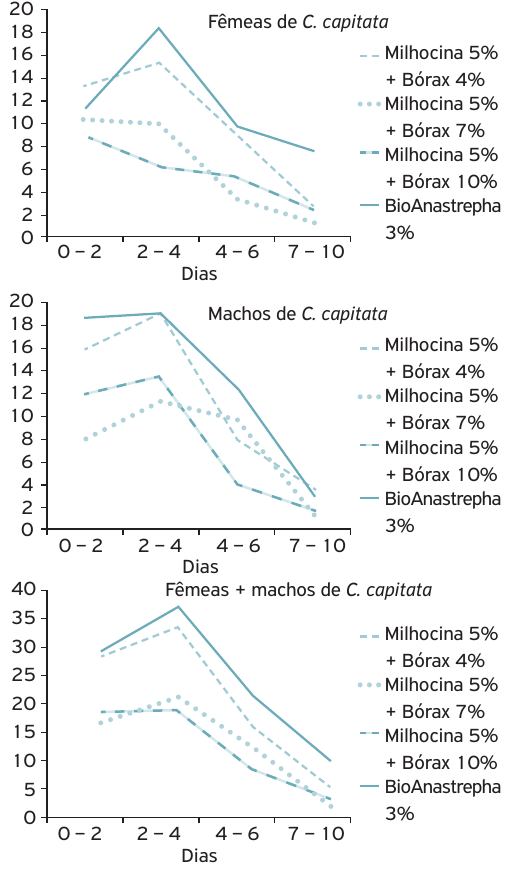
Figura 2. Número médio de adultos de C. capitata capturados